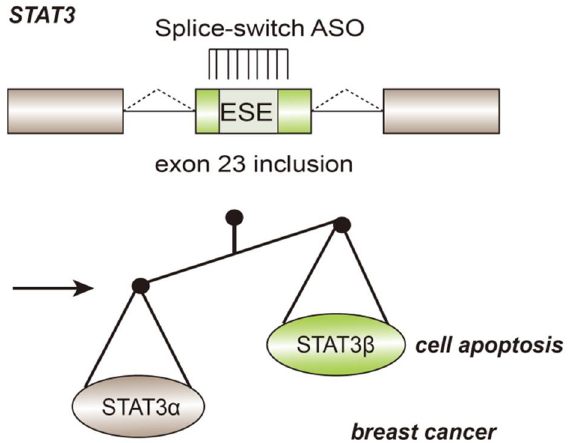
Figure 5. Application of splice-switch ASO in the treatment of breast cancer. Oncogene STAT expresses two isoforms: STAT3 α and STAT3 β . ASO targets the ESE and induce exon23 inclusion, thereby improving the production of STAT3β and leading to cell apoptosis in breast tumors.